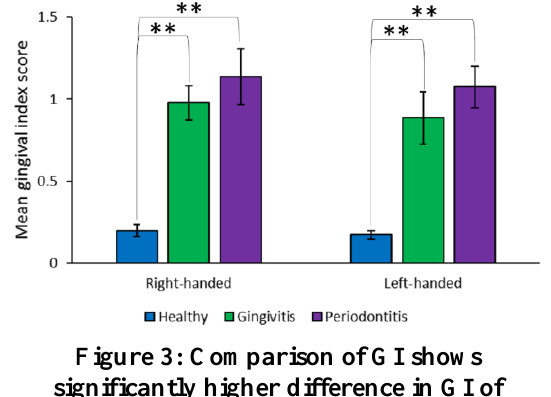
Figure 3: Comparison of GI shows significantly higher difference in GI of gingivitis and periodontitis groups as compared to healthy group in right- and left- handed individuals. *=P≤0.05,